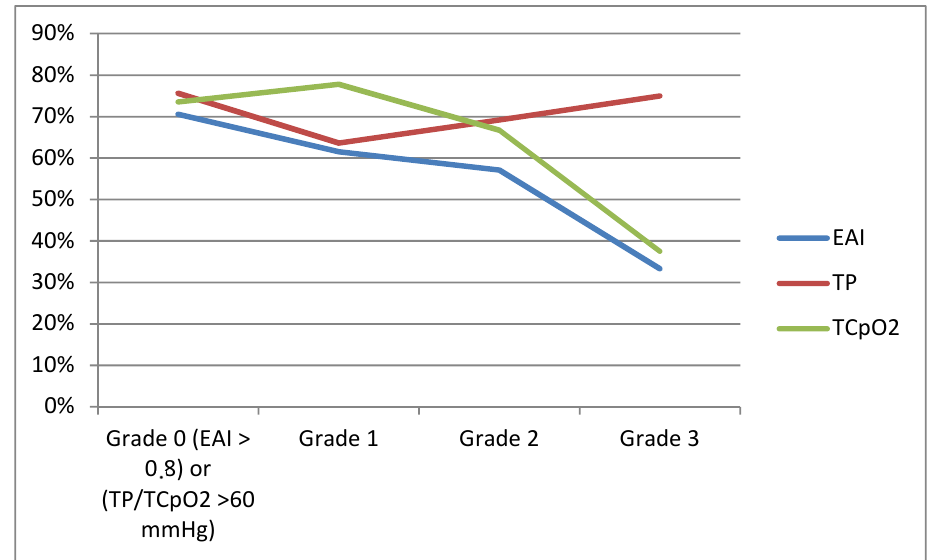
Figure 3. Vascular tests demonstrated within The Wound, Ischemia, and foot Infection WIfI classification grades. Ankle-Brachial Index (EAI), X-axis: Mean healing (%); Y-axis: ankle-brachial index (ABI), toe-pressure (TP) and transcutaneous oxygen tension measurement (TCpO2): Grade 0 (ABI > 0.8 or > 60 mmHg), Grade 1 (ABI 0.6–0.79 or 50–59 mmHg), Grade 2 (ABI 0.4–0.59 or 30–39 mmHg), Grade 3 (ABI < 0.39 or < 30 mmHg).* according to the WIfI classification grades.